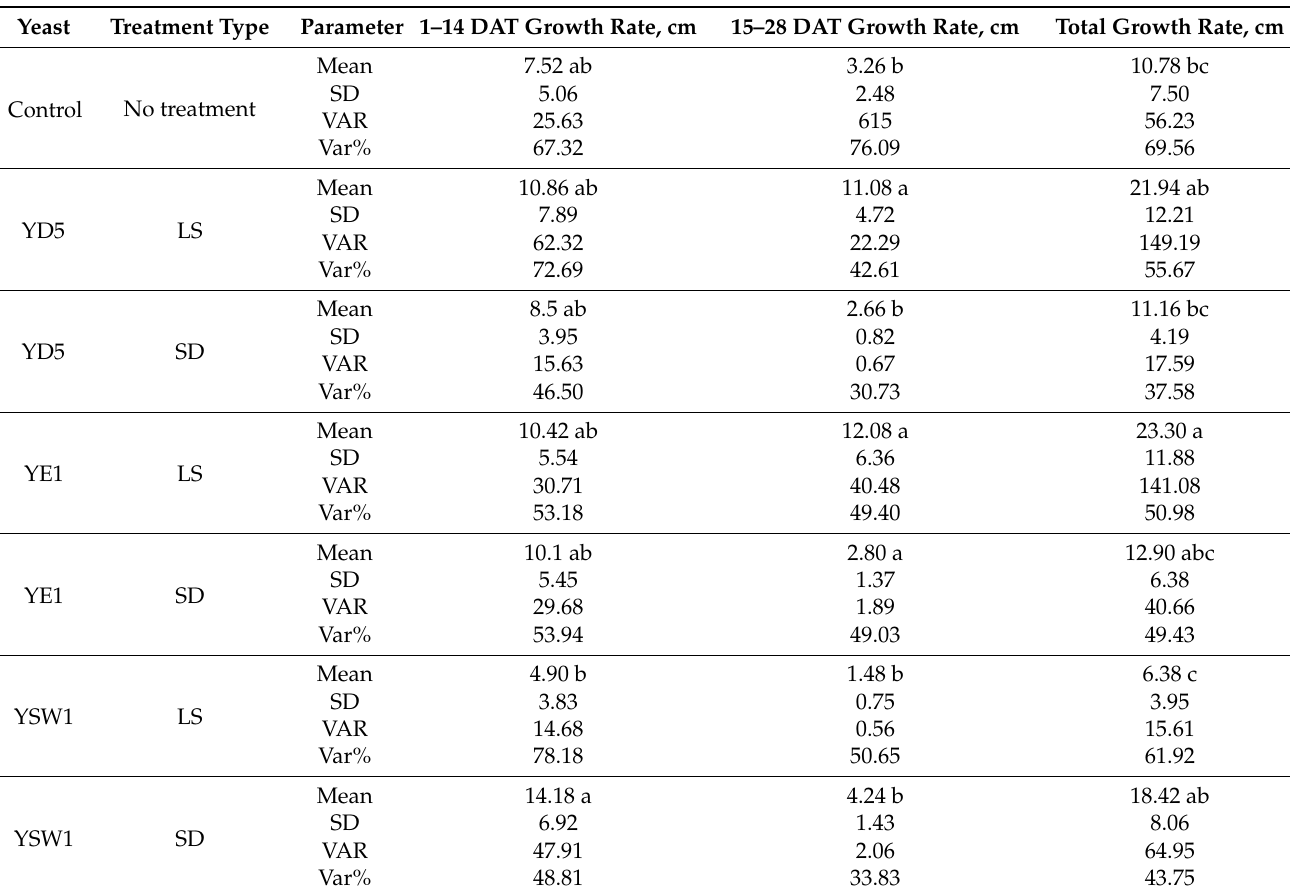
Table 4. Growth rate of tobacco plants during the experimental period, monitored at 7th, 14th and 28th DAT (single